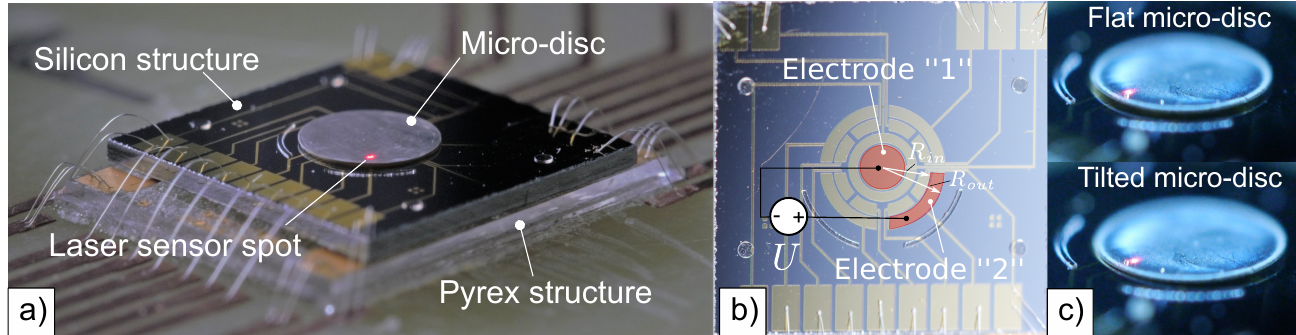
Figure 1. The prototype of micro-actuator-performed tilting pull-in actuation: ( a ) the fabricated prototype of the micro- actuator glued and wire-bonded on a PCB board and levitated stably micro-disc with a diameter of 2.8 mm; ( b ) the set of electrodes fabricated on the top of the silicon structure: the energized electrodes generating the electrostatic forces executing the pull-in actuation are highlighted in red, where U is the applied voltage; ( c ) video frames demonstrating actual tilting pull-in actuation: the top figure shows the original flat state of the micro-disc and the bottom figure shows its tilted state after applying the pull-in